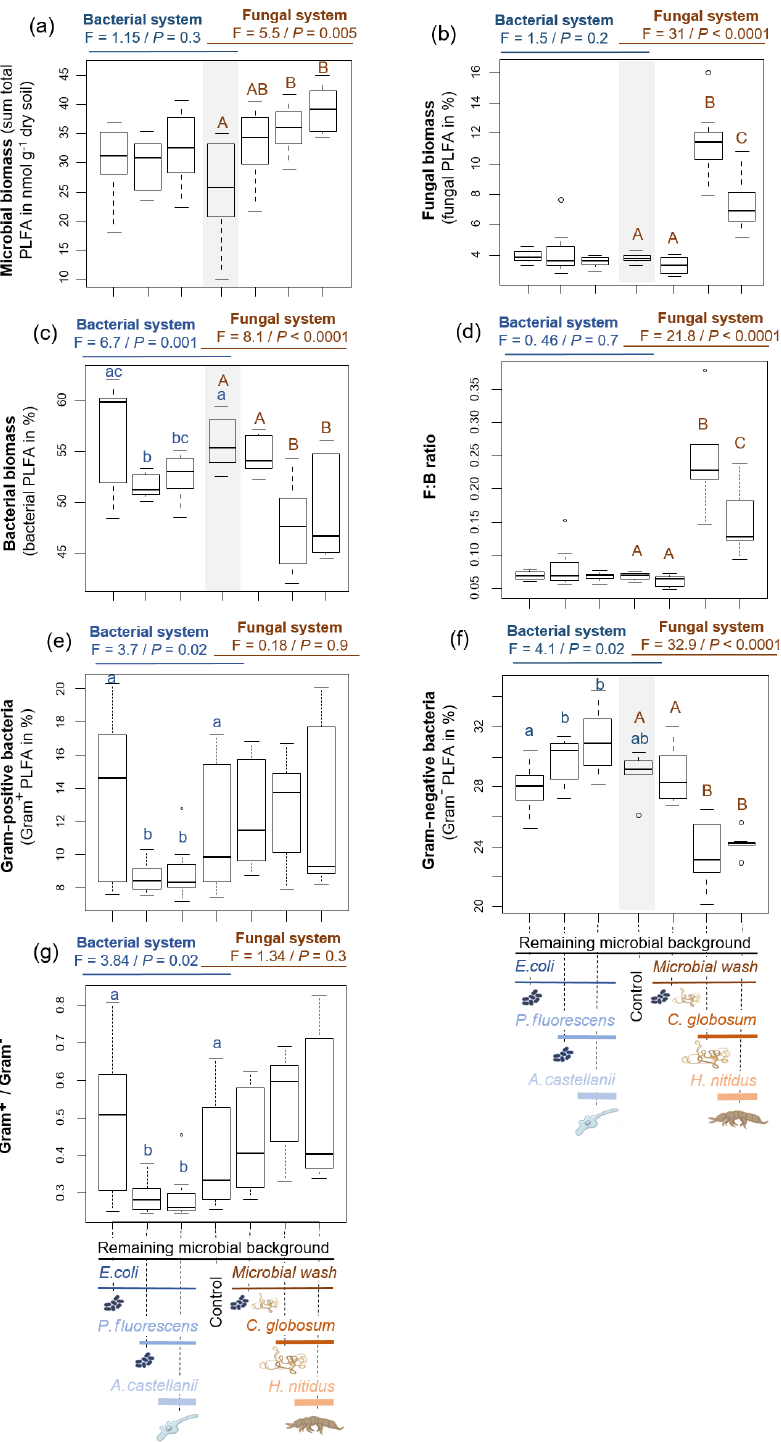
Figure 1. Effect of bacterial and fungal consumer–prey inoculations on microbial biomass and composition. (a) Microbial biomass, (b) fungal biomass, (c) bacterial biomass, (d) fungal:bacterial PLFA ratio (F : B), proportion of (e) Gram + bacteria and (f) Gram − bacteria, and (g) ratio between Gram + and Gram − bacteria. Differences between treatments were analysed separately for the bacterial and fungal systems using GLS models followed by ANOVA and post hoc Tukey tests. Letters (blue lowercase for bacterial system and brown capital for fungal system) indicate significant differences between means according to Tukey tests. Grey background indicates control treatment of bacterial and fungal